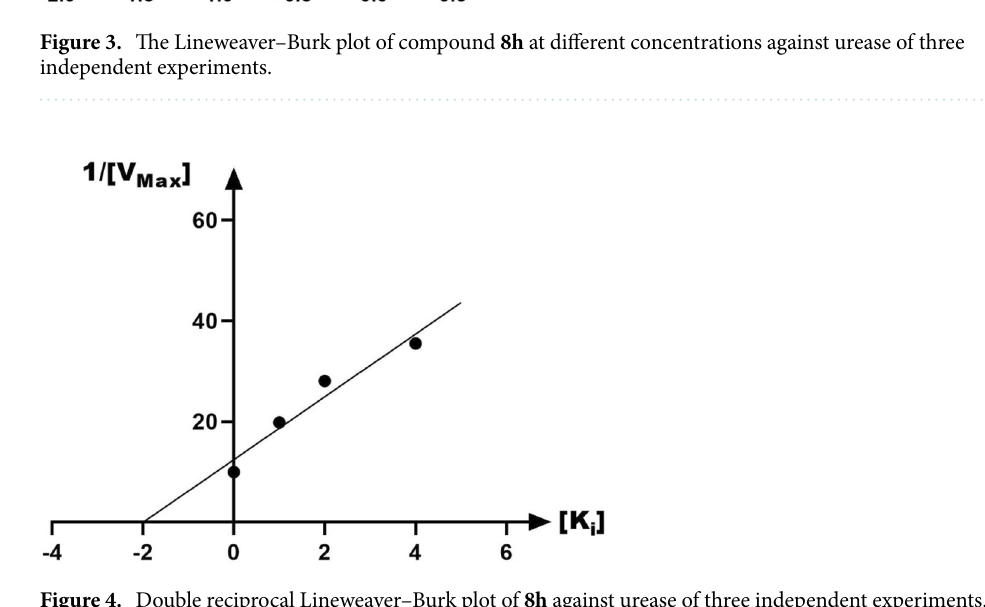
Figure 4. Double reciprocal Lineweaver–Burk plot of 8h against urease of three independent experiments.